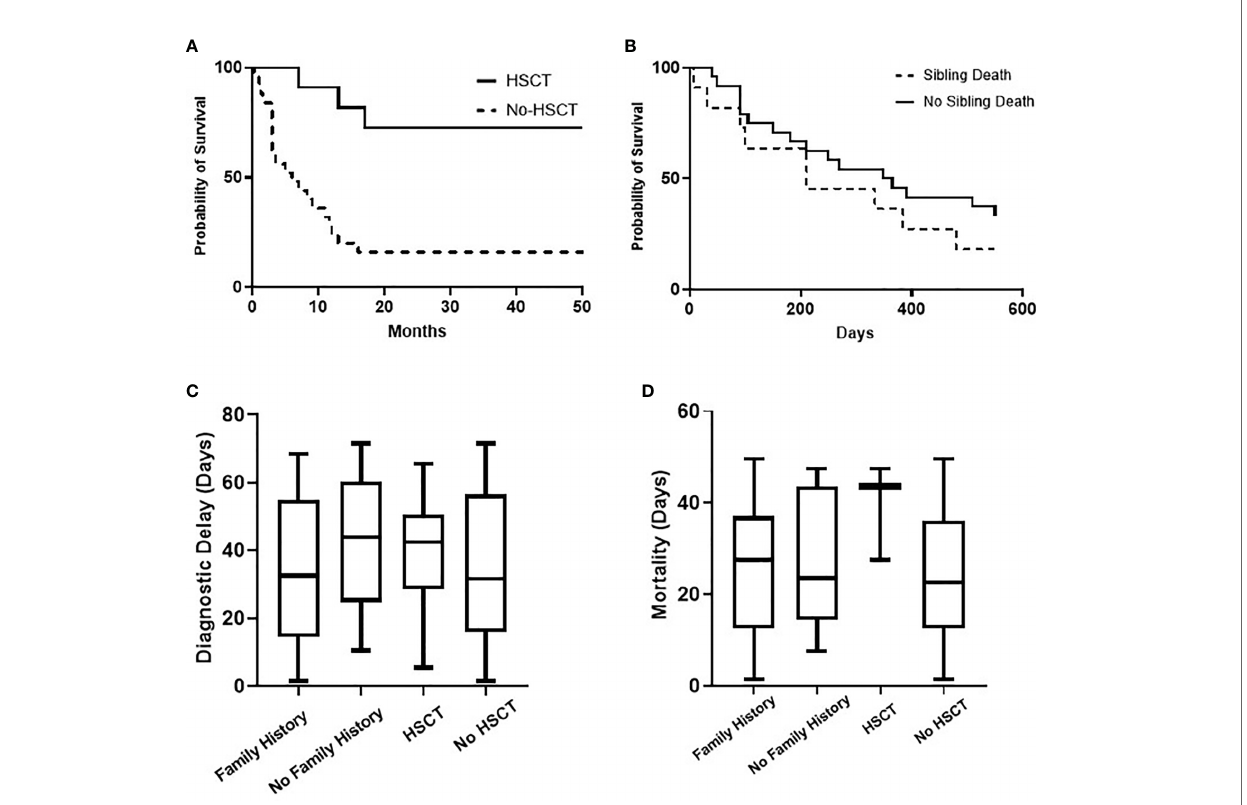
FIGURE 2 | Overall probability of survival (Kaplan-Meier curve) of children with SCID for HSCT (P value = 0.0003) and for the presence of sibling death (P value = 0.2923), (A, B) . Comparative analysis (Kruskal-Wallis test) for diagnostic delay (P value = 0.5702) and mortality age (P value = 0.3427) in relation to family history and HSCT, (C, D)